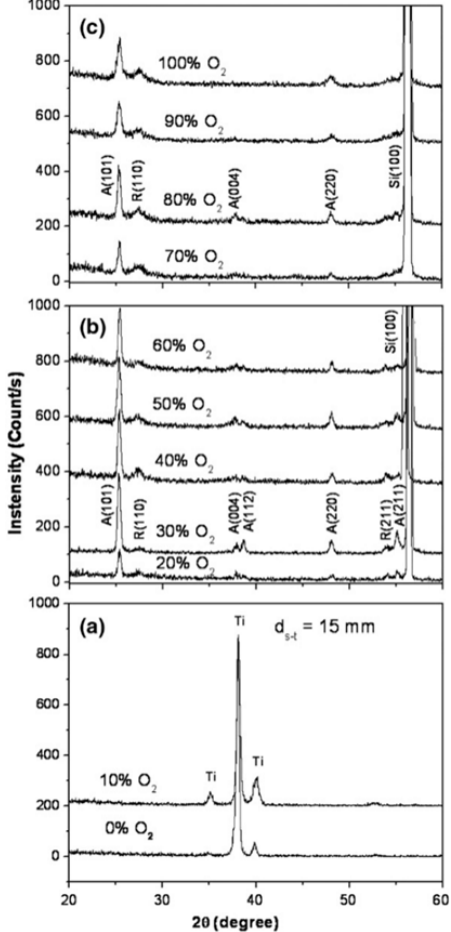
Figure 8. XRD patterns of TiO 2 films deposited on silicon (100) at various O 2 concentrations in Ar/O 2 gas mixture. Reprinted with permission from [107], copyright 2008,